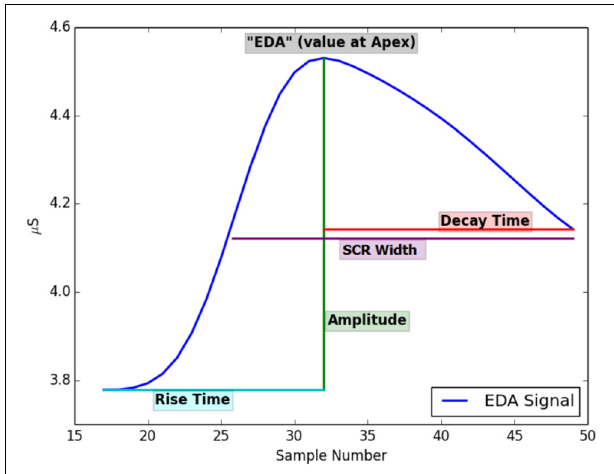
FIGURE 2 | Features that can be extracted from an EDA signal. Printed with permission from Taylor et al. (2015).